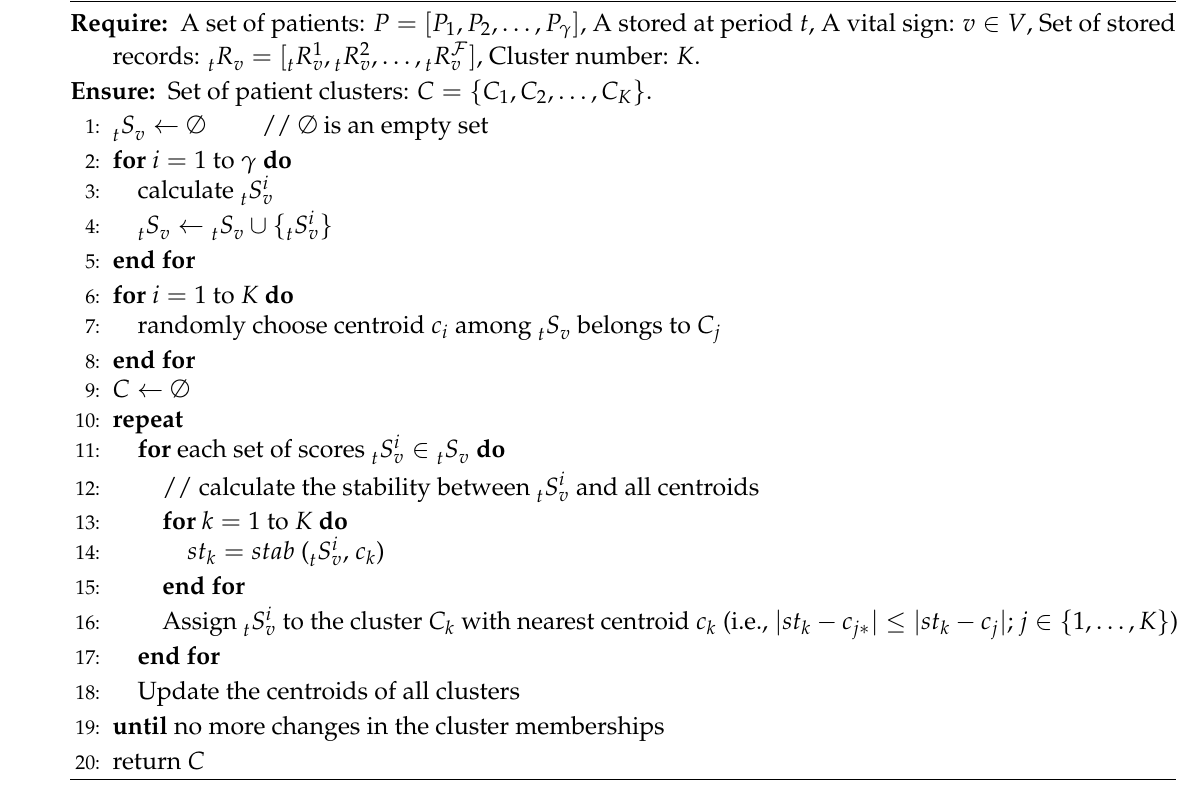
Algorithm 2 SKmeans